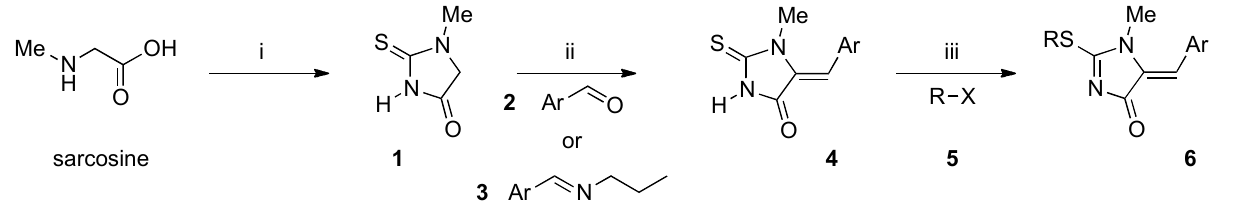
Reagent and reaction conditions: (i) NH